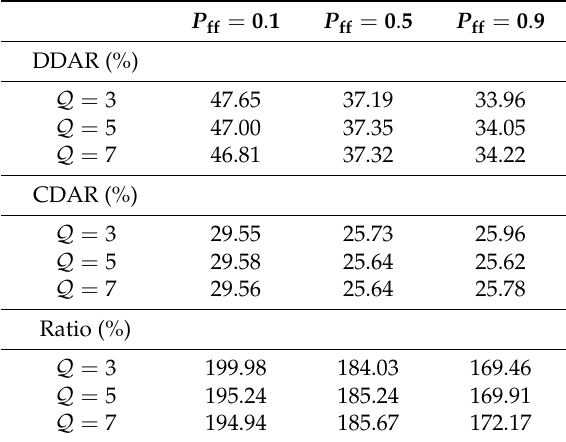
Table 10. Average energy efficiency and the ratio vs. P α